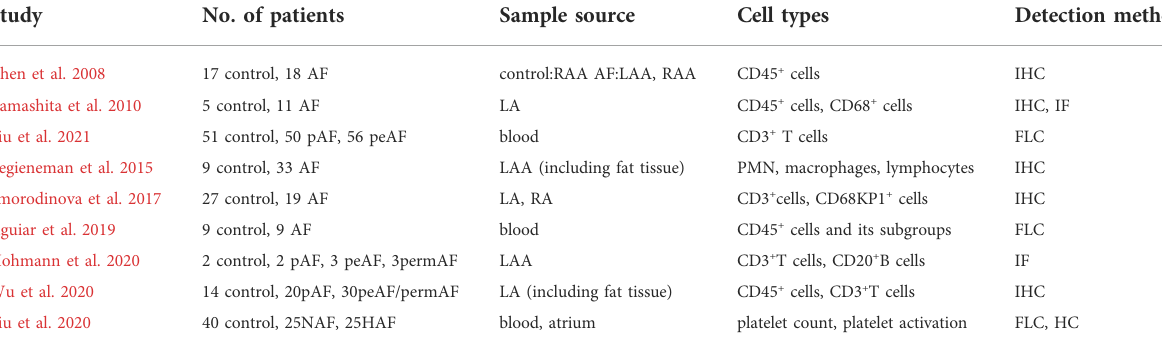
TABLE 1 The main studies on the change of immune cells in